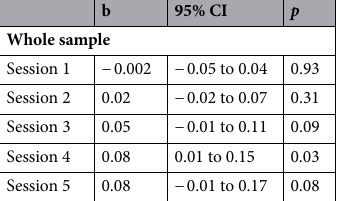
Table 2. Behavioural performance in implicit learning as measured by MCC. CI confidence interval, b beta coefficient of task performance during training sessions